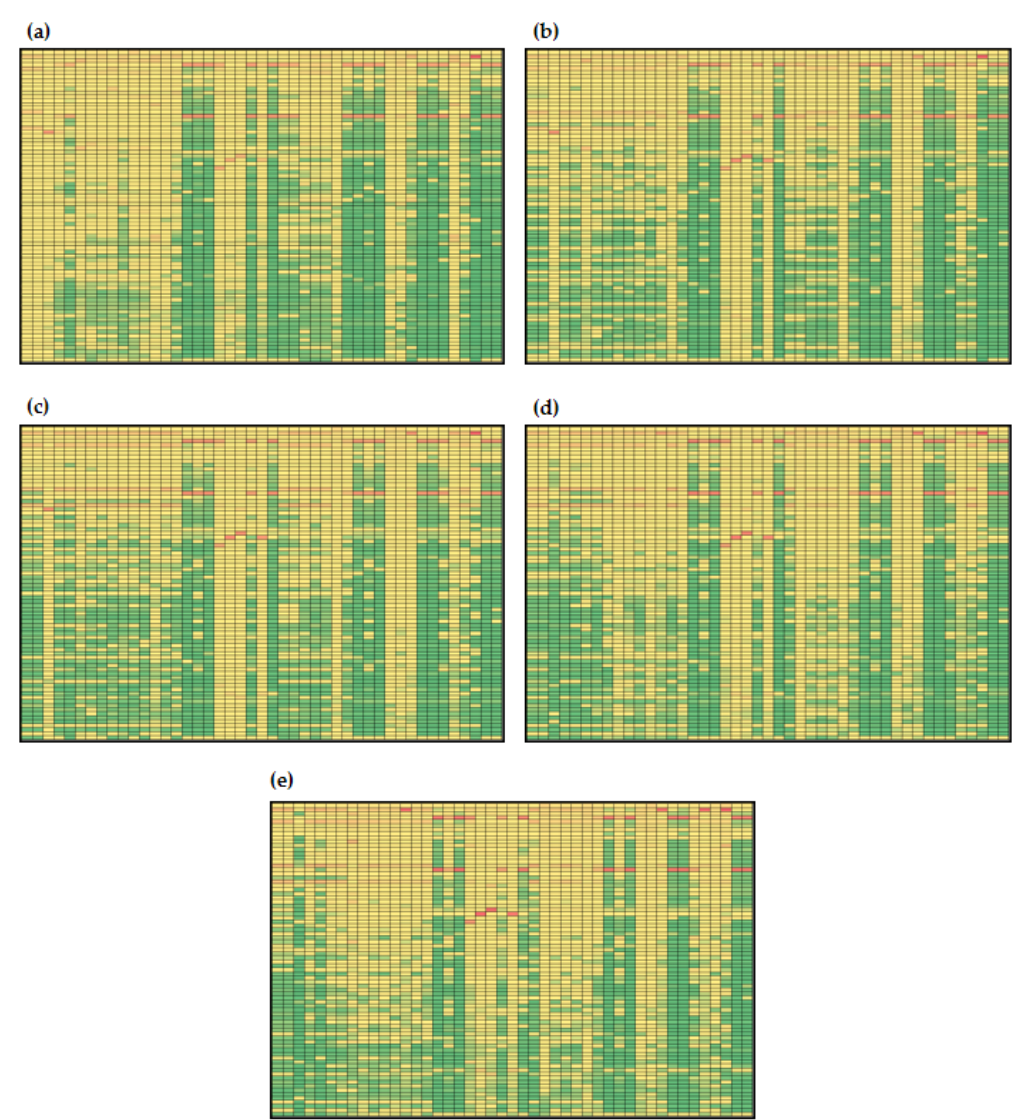
Figure 7. Global sensitivities of hepatic lipid model reactions (initial conditions for simulations according to Menu 1): ( a ) t f = 10 min, ( b ) t f = 50 min, ( c ) t f = 100 min, ( d ) t f = 250 min, ( e ) t f = 500 min. Rows: β G , β 6 , β f , β l , β m , µ AMP , µ e , µ s , µ 1 , µ 2 , µ 3 , µ 4 , c 0 , c c , d BA , k 10 , k 11 , k 12 , k 13 , k 14 , k 22 , k 5 , k 6 , k 6l , k 6p